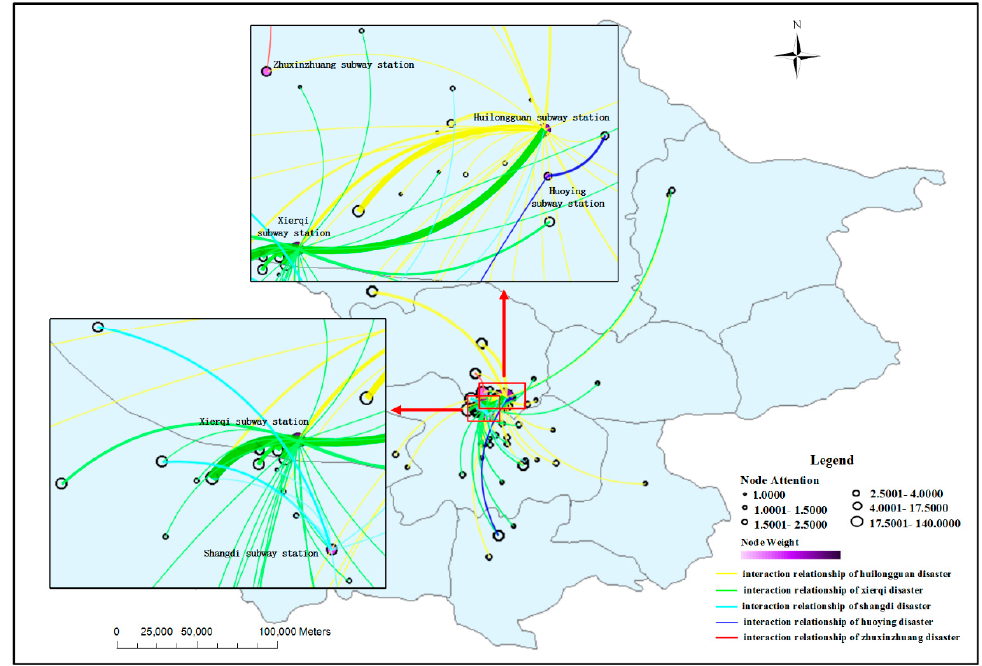
Figure 5. Geospatial distribution of influence for selected nodes on the 16th.